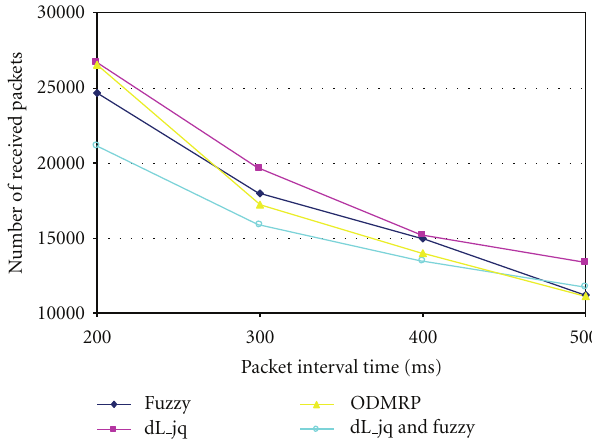
Figure 14: Overall overhead per a data packet.